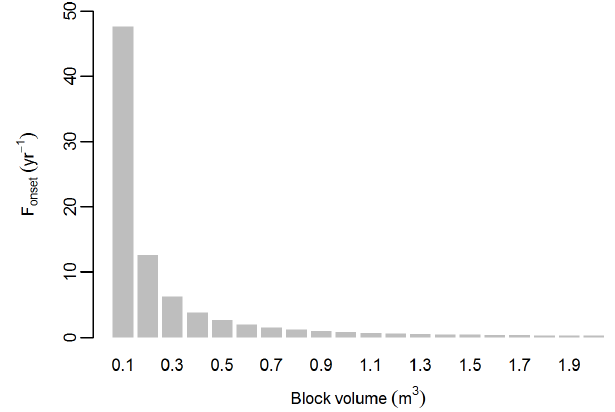
Figure 2. Expected onset frequency (blocks released per year) on the virtual slope. Calculations are based on a power-law volume– frequency relationship, where β is the power-law exponent of the cumulative volume frequency distribution and calculated at 0.7, and where α was set to 12.